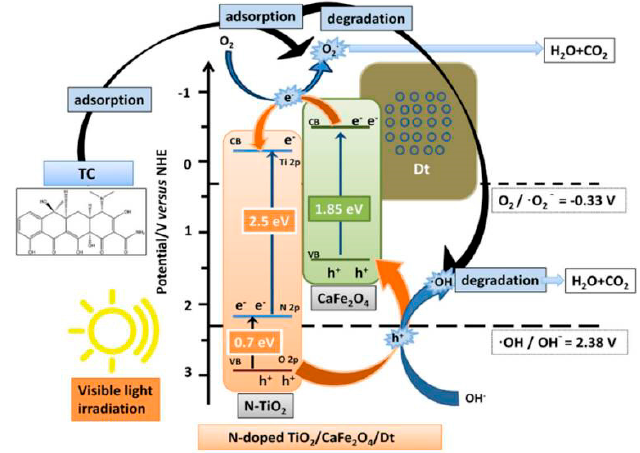
Figure 4. Proposed mechanism for the tetracycline (TC) photodegradation process using N-doped TiO 2 /CaFe 2 O 4 / diatomite [44].